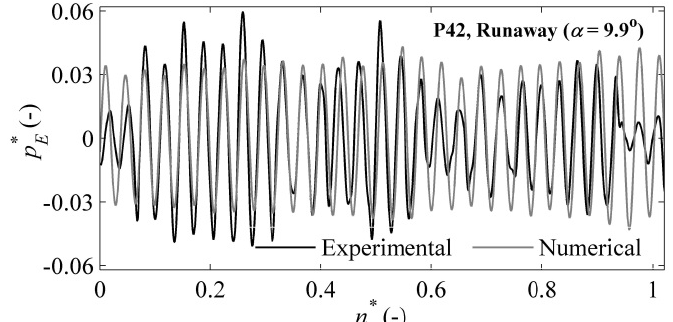
Figure 10. Instantaneous pressure fluctuations at the blade pressure side (P42) over a complete rotation of the runner for the runaway operating point α = 9.9 ˝ ; the fluctuations correspond to the rotor stator interaction and a guide vane passing frequency of 244.7 Hz.